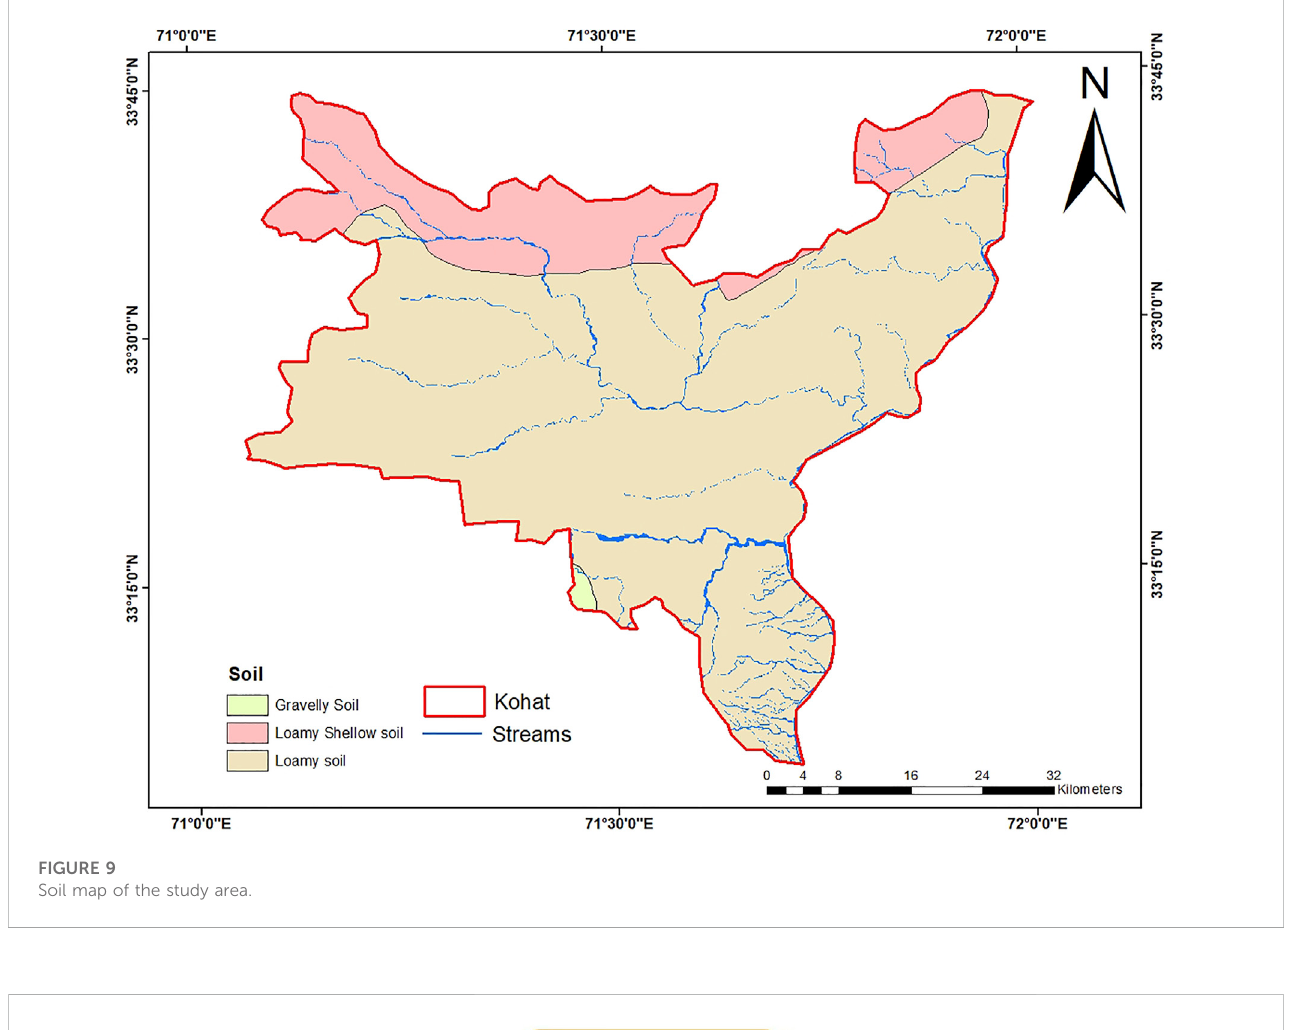
FIGURE 9 Soil map of the study area.